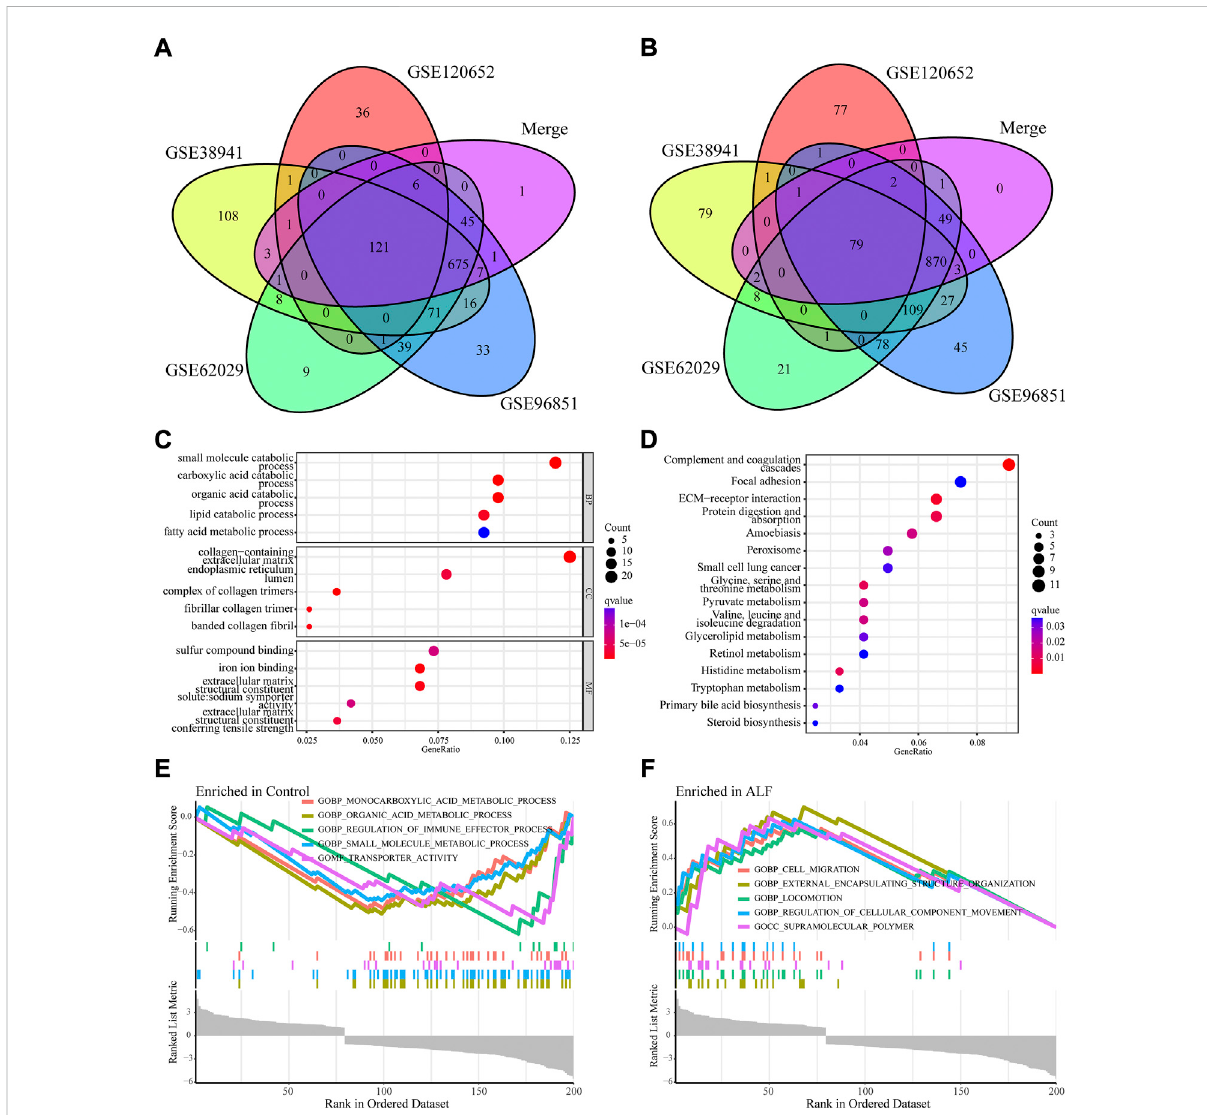
FIGURE 3 Function and pathway enrichment analysis of co-DEGs. (A) Venn diagram to identify co-downregulated DEGs between normal and ALF. (B) Venn diagram to identify co-upregulated DEGs between normal and ALF. (C) GO analysis of Co-DEGs. (D) KEGG analysis of Co-DEGs. (E,F) GSEA analysis of all